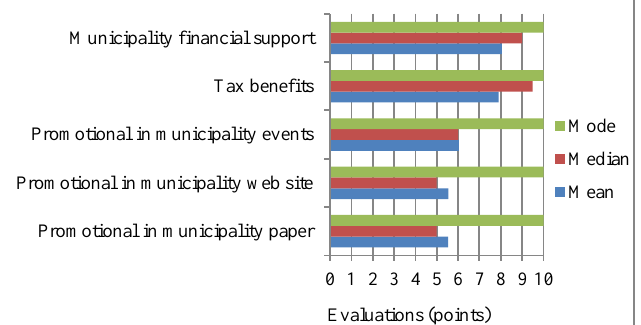
Fig. 3. Average (mean, median and mode) indicators of employers’ evaluation of municipality motivation activities for involvement of vocational education students by company. Source: compiled by authors based on employers’ survey, 2013 ( n = 336). Evaluation scale 1–10, where 1 – not significant; 10 – very